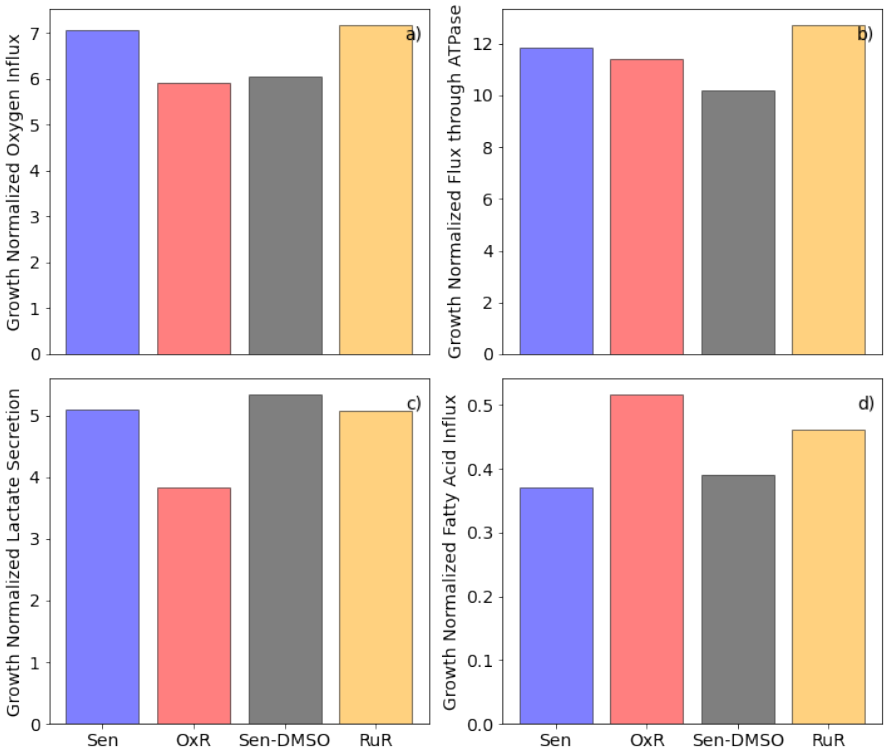
Figure 3. Comparison of fluxes through key energy metabolism reactions for ruthenium- and oxaliplatin-based resistant cells after growth rate normalization. Growth normalized flux values through ( a ) the oxygen uptake reaction—HMR_9048, ( b ) the ATP synthase reaction—HMR_6916, ( c ) the lactate secretion reaction—HMR_9135, and ( d ) the fatty acid influx—sum of m01362s_FAx, m02387s_FAx, m02389s_FAx, m02646s_FAx, m02674s_FAx, m02938s_FAx, across the four model instances (sensitive, Sen—blue bars; sensitive in a DMSO-containing medium, Sen-DMSO—gray bars; oxaliplatin-resistant, OxR—red bards; BOLD-100/KP1339, RuR—yellow bars) are shown. Fatty acid influx is the combined influx of stearate, palmitate, oleate, linolenate, linoleate,